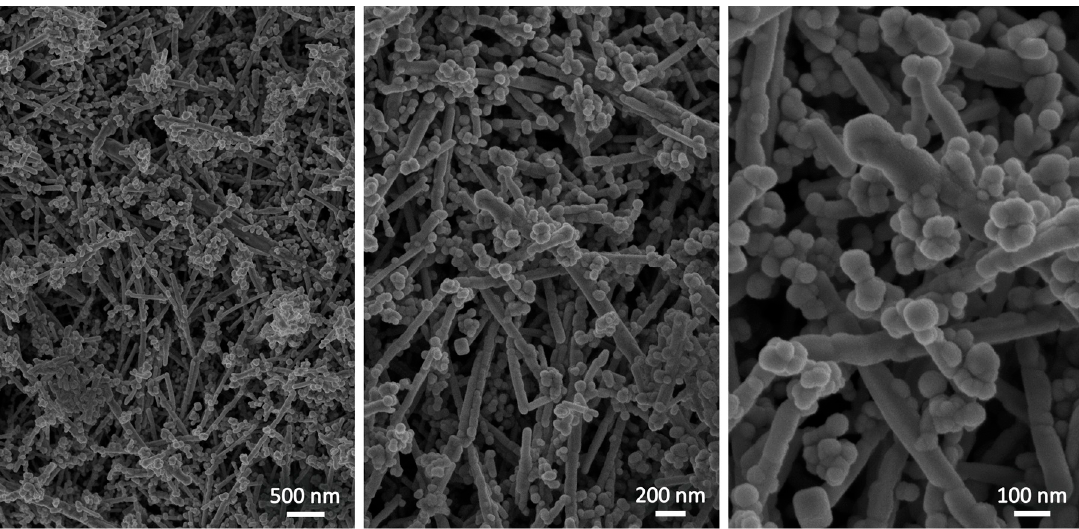
Figure 1. XRD diffractograms of the Ce50Pr50 catalyst and of pure ceria.